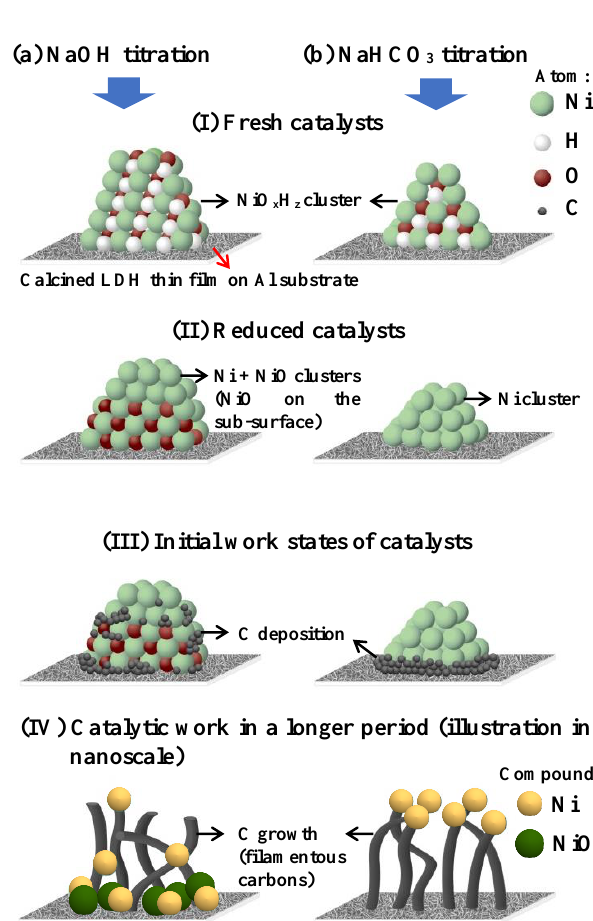
Figure 12. Schematic mechanisms illustrate the processes of carbon formation on the surfaces of the catalysts (Ni on calcined LDH) in the ESR reactions: ( a ) NaOH titrated catalysts and ( b ) NaHCO 3 titrated catalysts. The preparations of the catalysts and in the ESR reactions present in (I) – (IV): (I) Fresh catalysts; (II) Reduced catalysts; (III) Initial states of catalysts in the ESR reactions; (IV) NaOH titrated catalyst shows the formation of filamentous carbons burying gradually on the Ni and NiO particles; NaHCO 3 titrated catalyst shows that the Ni particles raise on the tips of the filamentous carbons. Note: The illustrations in (I) – (III) show processes in atomic scales, and (IV) shows in na- noscale.